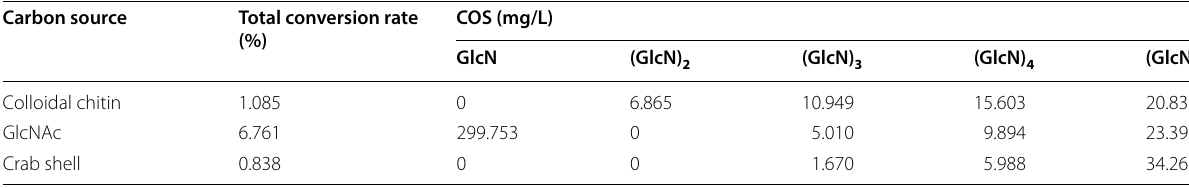
Table 2 Results for transformation of COS by Streptomyces diastaticus CS1801 Carbon source